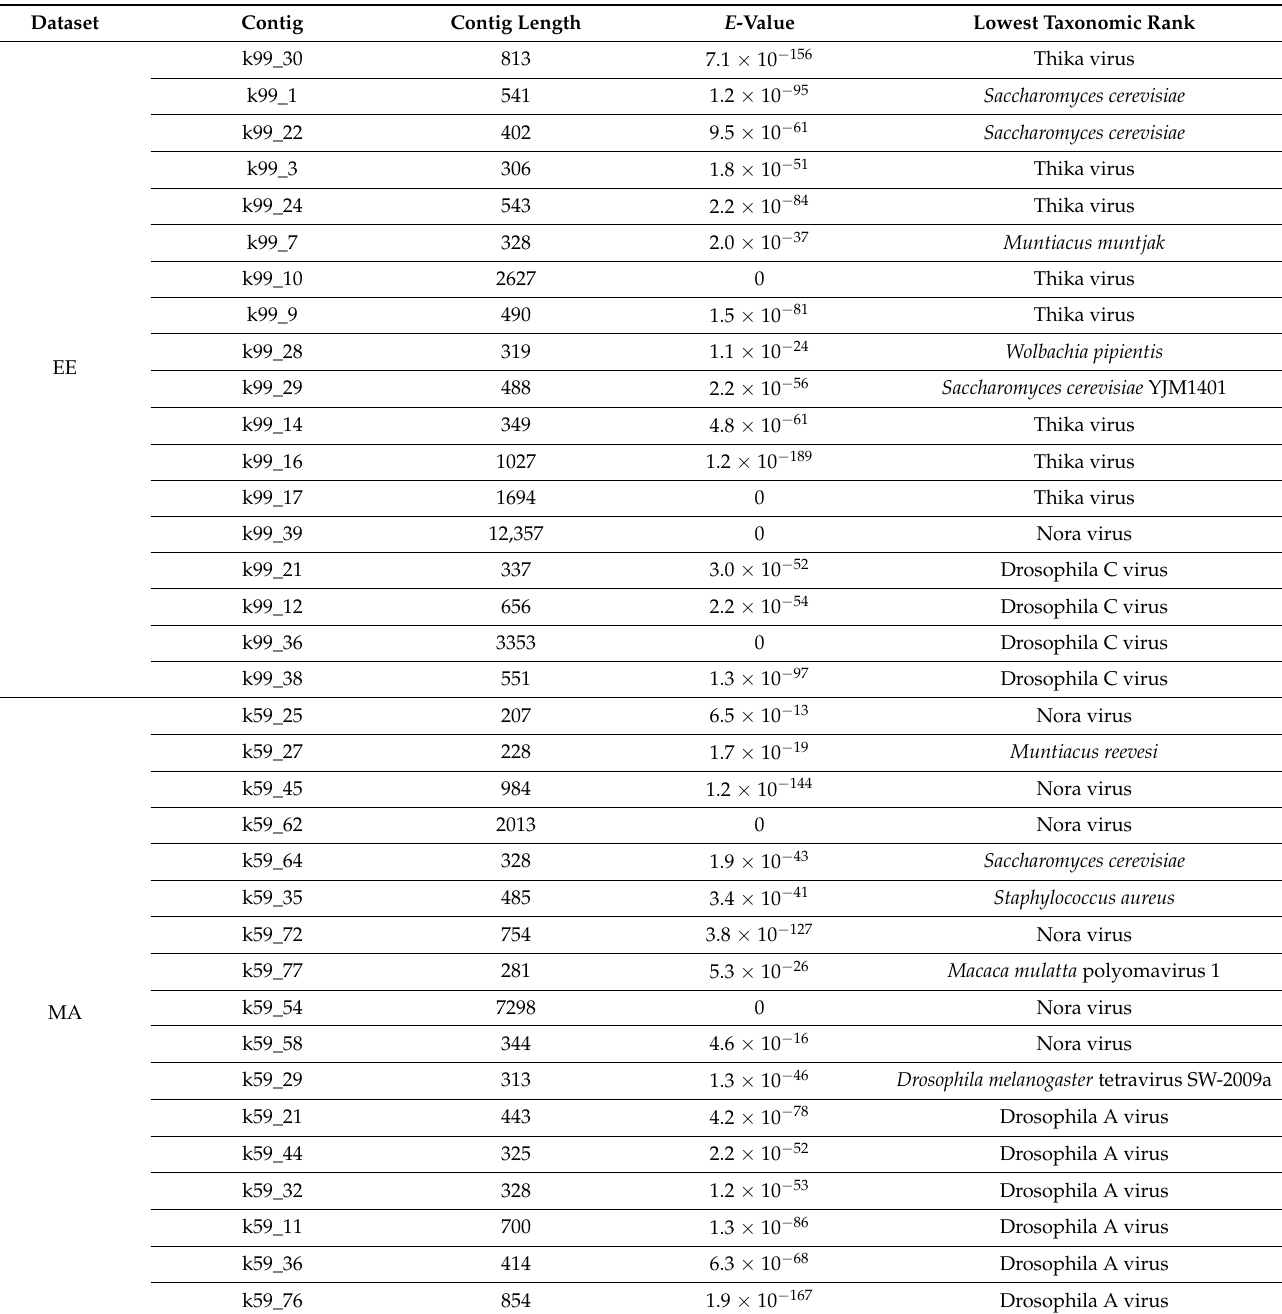
Table 1. DIAMOND BLASTX results. Hits to Drosophila and synthetic constructs were